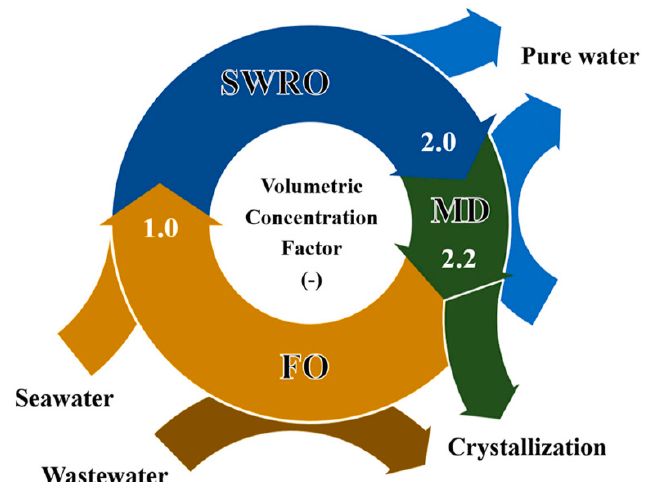
Figure 15. Concept of the MD–SHFCC desalination system. Reprinted from [106]. Copyright (2018) with permission from Elsevier.